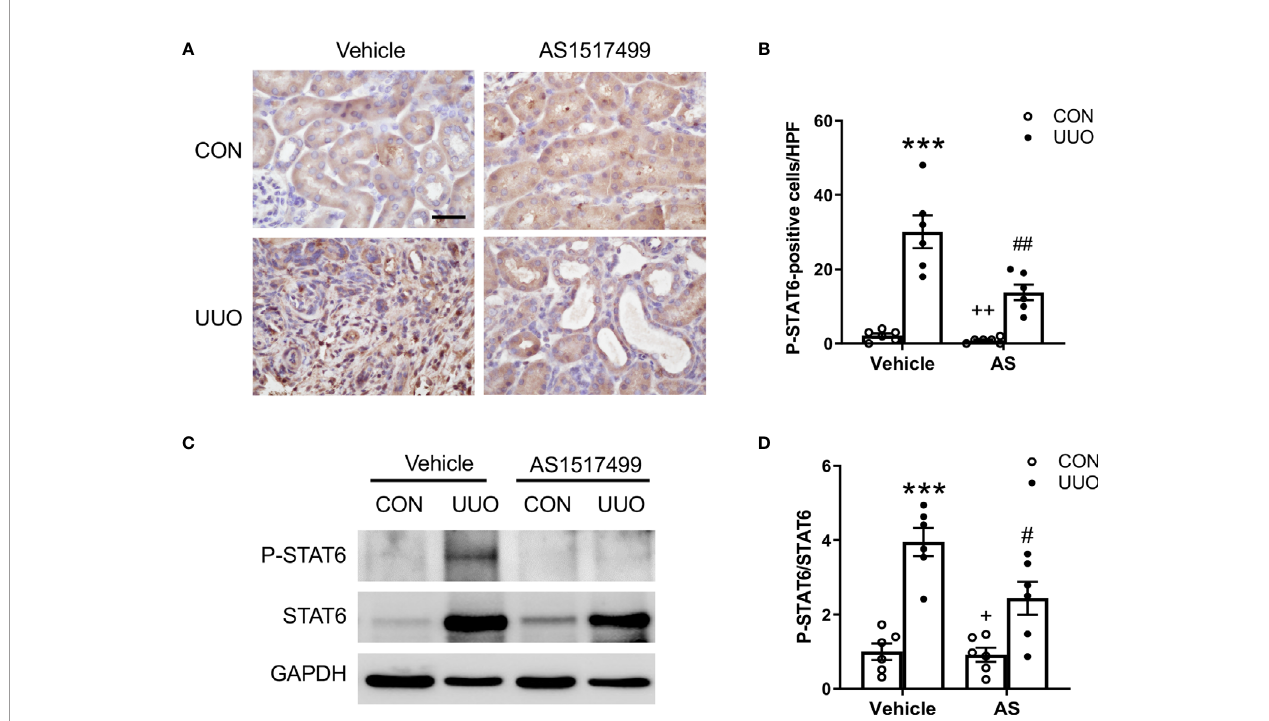
FIGURE 1 | AS1517499 inhibits STAT6 activation in the kidney with obstructive injury. (A) Representative photomicrographs of kidney sections at day 10 of UUO stained for phosphorylated STAT6 (brown) and counterstained with hematoxylin (blue). Scale bar, 50 m m. (B) Quantitative analysis of phosphorylated STAT6-positive cells in the kidney. *** P < 0.001 vs . Vehicle-CON; ## P < 0.01 vs Vehicle-UUO; ++ P < 0.01 vs AS-UUO. n = 6 per group. (C) Representative Western blots show protein levels of p-STAT6 and STAT6 in the kidney at day 10 of UUO. (D) Quantitative analysis p-STAT6 protein levels in the kidney. *** P < 0.001 vs . Vehicle-CON; # P < 0.05 vs Vehicle-UUO; + P < 0.05 vs AS-UUO. n = 6 per